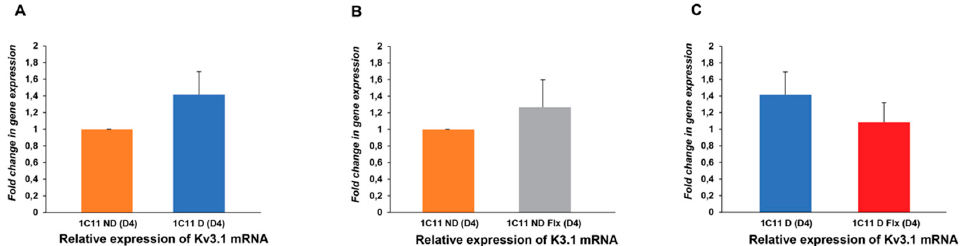
Figure 4. Fluoxetine effect on the Kv3.1b mRNA level in the 1C11 cell line in the culture. The Kv3.1b mRNA level is measured with qRT-PCR. ( A ) The histograms show a significant increase of the Kv3.1b mRNA level in differentiated cells compared to not-differentiated cells. Fluoxetine increases mRNA transcripts in culturing cells 1C11ND(D4) ( B ) but significantly decreases the mRNA level in differentiated cells ( C ). 1C11ND(D4) (cells in culture) and 1C11 D (differentiated cells 1C115-HT(D4))-. 1C11DFl × (1C11-5HT + FLX 10 nM(D4) and 1C11 NDFlx (1C11ND + FLX10 nM(D4); n = 3). Fold change in gene expression is calculated using the 2 ΔΔ CT method [34]. Data from 3 different independent cultured 1C11 cell lines, with 3 replicates for each condition (1C11ND, 1C11D, 1C11NDFlx and 1C11DFlx). An analysis by unpaired Student’s t-test is used to compare the means between two populations of Kv3.1b channels in the control condition or in the presence of fluoxetine. p < 0.05.